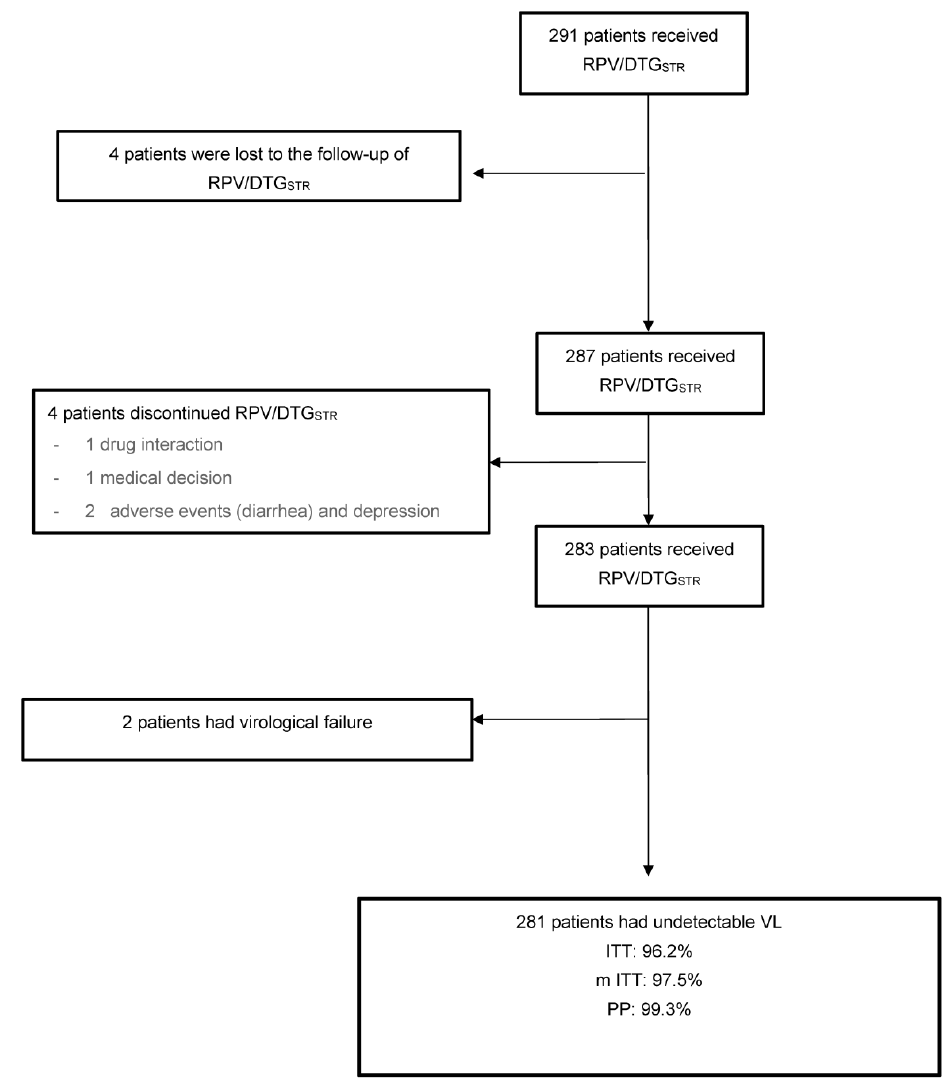
Figure 1. Flowchart of patients with rilpivirine plus dolutegravir (STR).